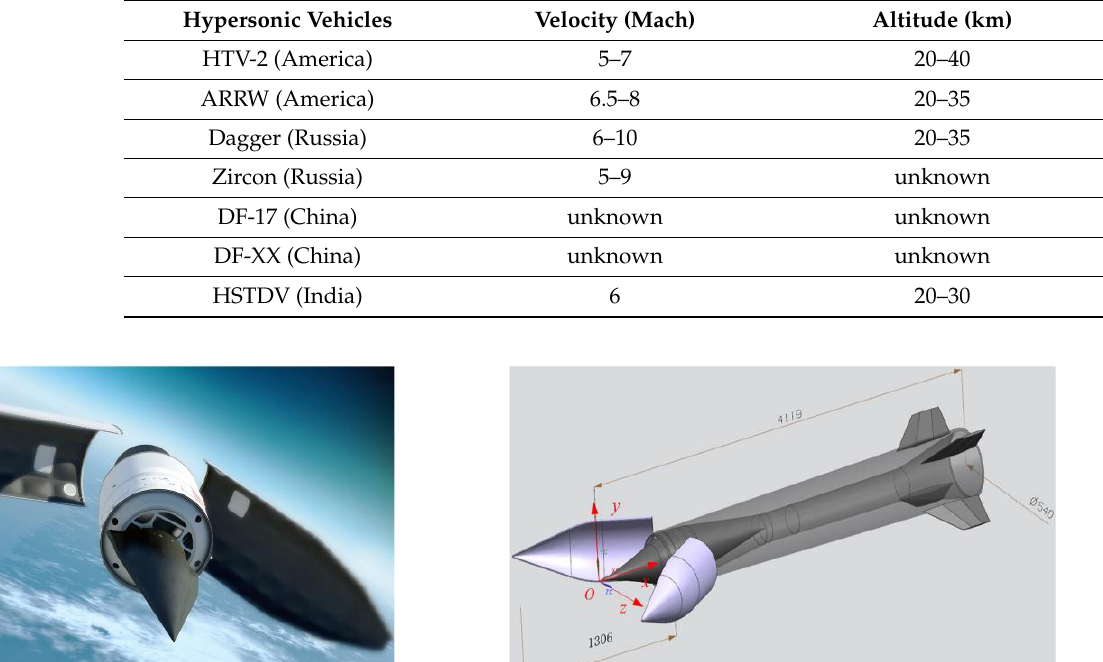
Table 1. Typical hypersonic vehicles in the low-altitude near space.